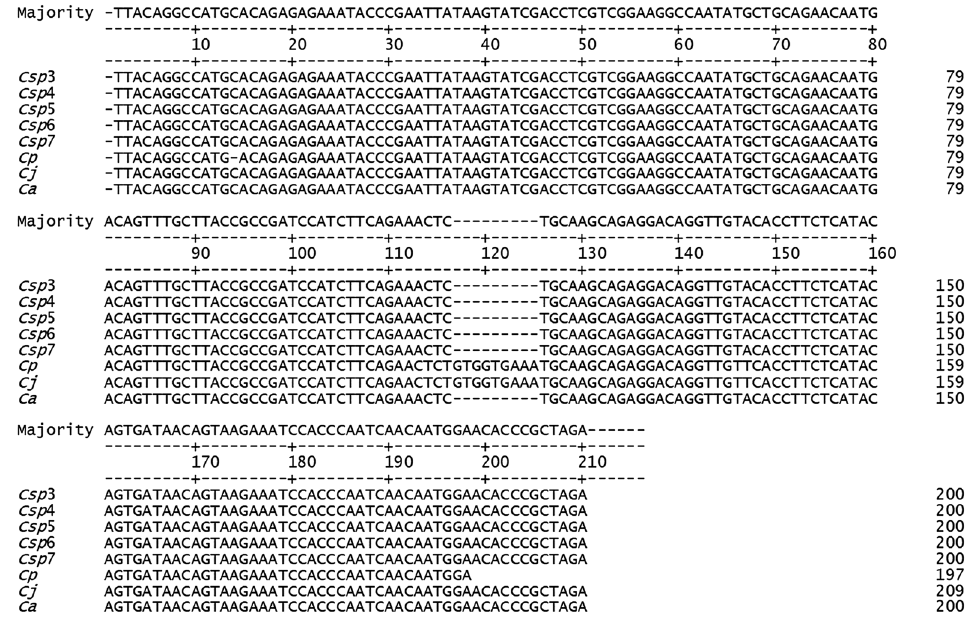
Figure 3. Alignment sequence of 210 base pairs (bp) of the SRY (sex-determining region Y) gene in five Callithrix sp. males ( Csp 3, Csp 4, Csp 5, Csp 6 and Csp 7) and one male of each C. penicillata ( Cp ), C. jacchus ( Cj ) and C. aurita ( Ca ). The dashes indicate the nine base pair deletion 117_125delTAA GTA TCG observed in C. aurita and in the five Callithrix